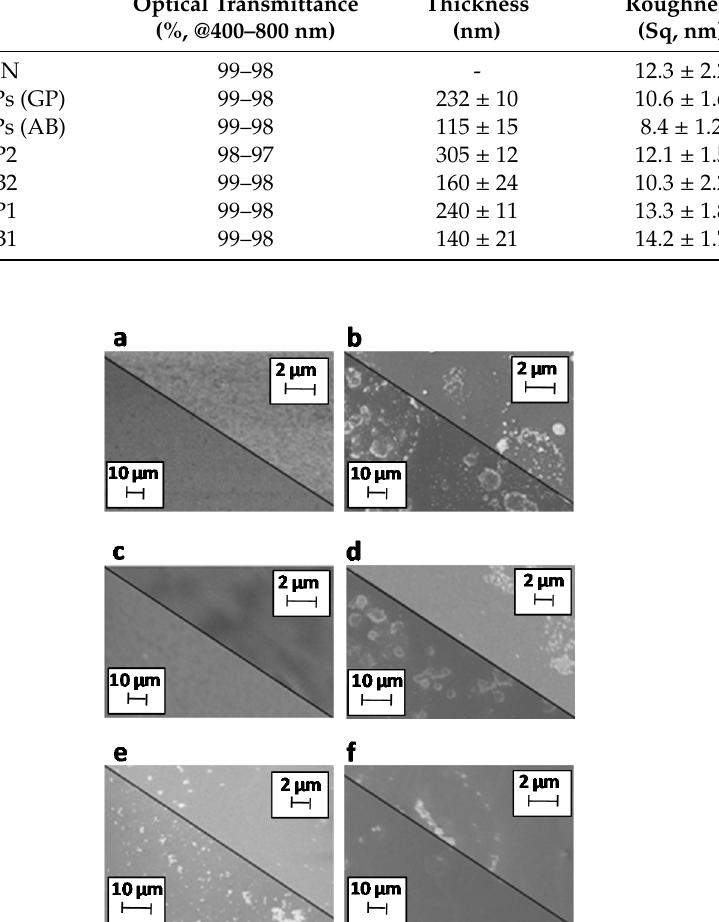
Table 1. Morphological and optical characteristics of the ZnONPs / stearic acid coatings.